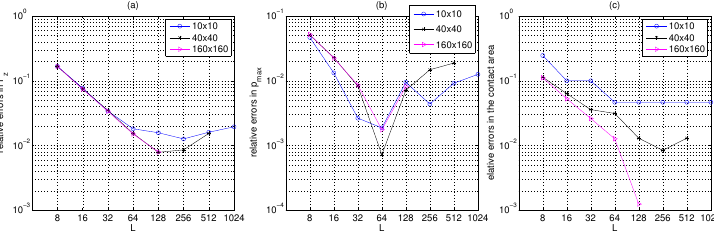
Figure 11. Normal contact problem with ICs by a piecewise constant load on prismatic Mesh2: (a) errors in the normal force, (b) errors in the maximal pressure, (c) errors in the contact